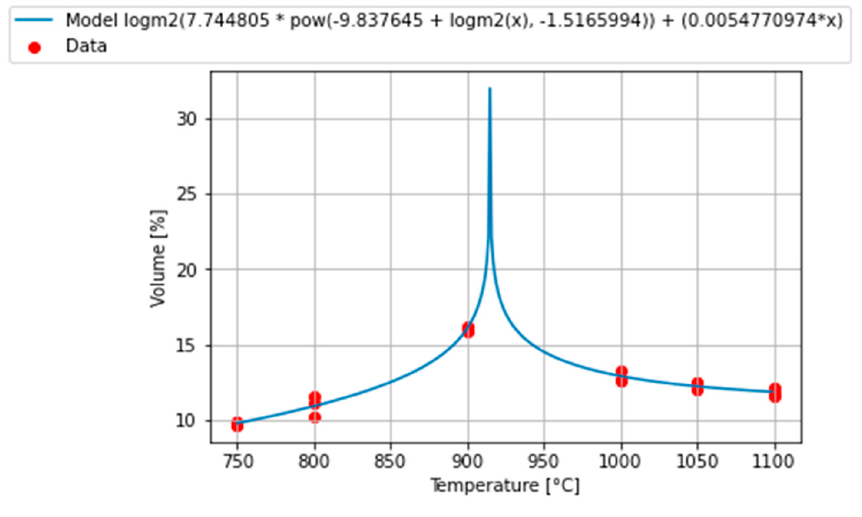
Figure 3. Model 2 of hydrogen H 2 .